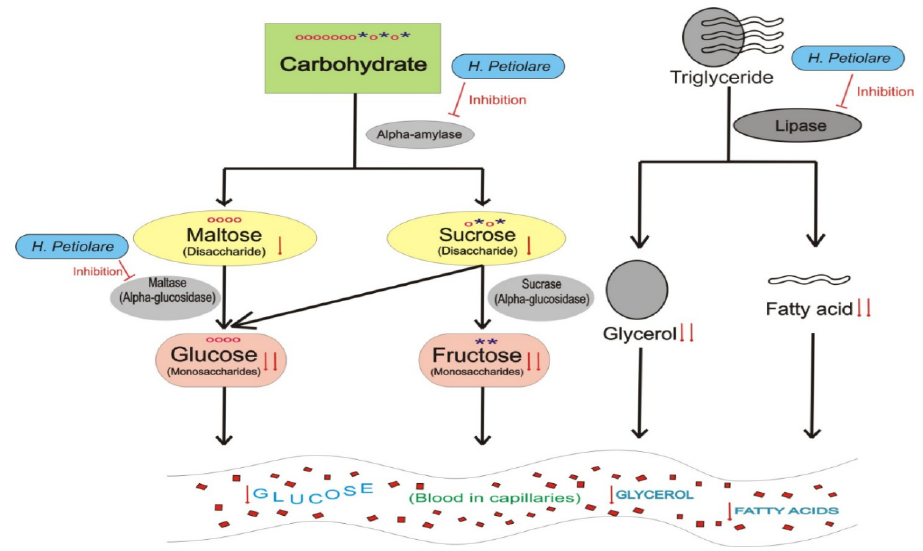
Figure 7. Summarises the possible effects of H. petiolare on α-amylase, α-glucosidase, and lipase activities in a human subject. The figure shows the hydrolysis of carbohydrate and triglyceride after treatment with H. petiolare respectively. “ ↓ ” indicates decrease, “ o ” represents a glucose molecule, and “*” represents a fructose